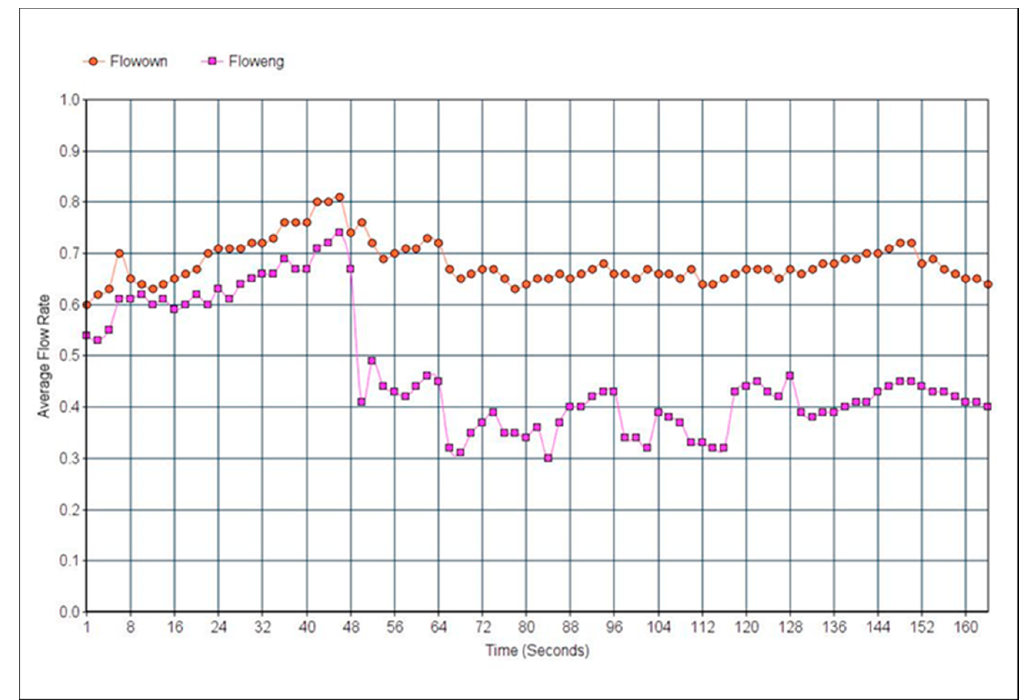
Figure 7. Average flow rate and reception flow time rates with 50% vehicle attacks. J. Sens. Actuator Netw. 2018 , 7 , x FOR PEER REVIEW